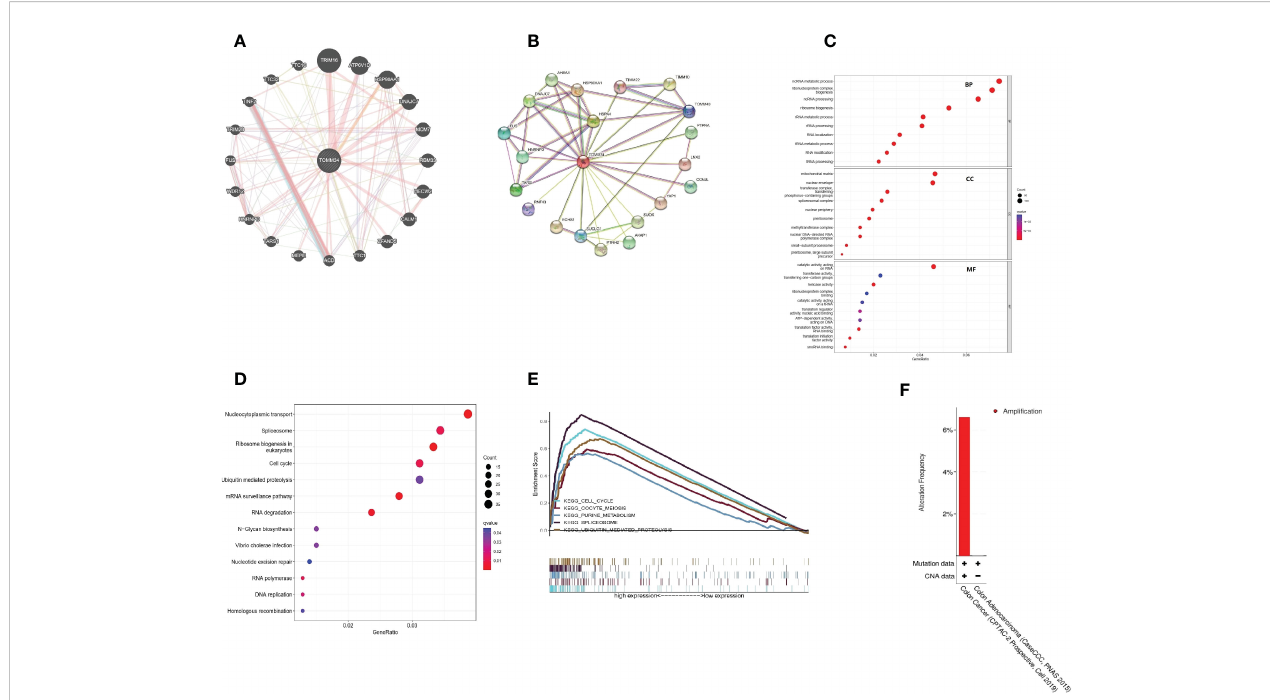
FIGURE 3 Interaction analysis of TOMM34-related genes and proteins and functional analyses. (A) Interaction analysis of related genes. (B) Interaction analysis of related proteins. (C) GO enrichment analysis. (D) KEGG pathway analysis. (E) GSEA based on KEGG analysis. (F) Genomic alteration type of TOMM34, revealing that the genomic alteration type of TOMM34 was ampli fi cation.